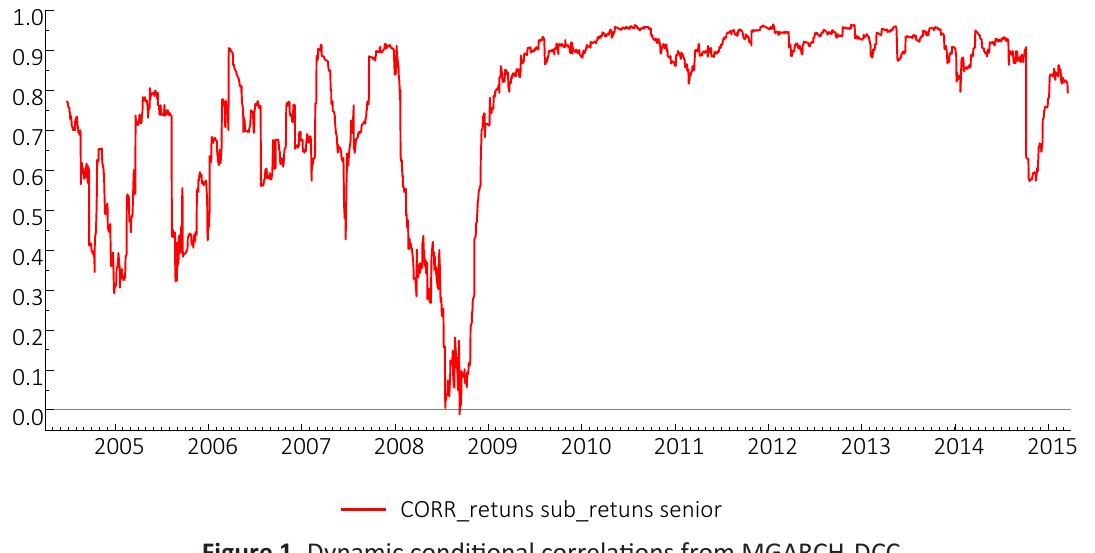
Figure 1. Dynamic conditional correlations from